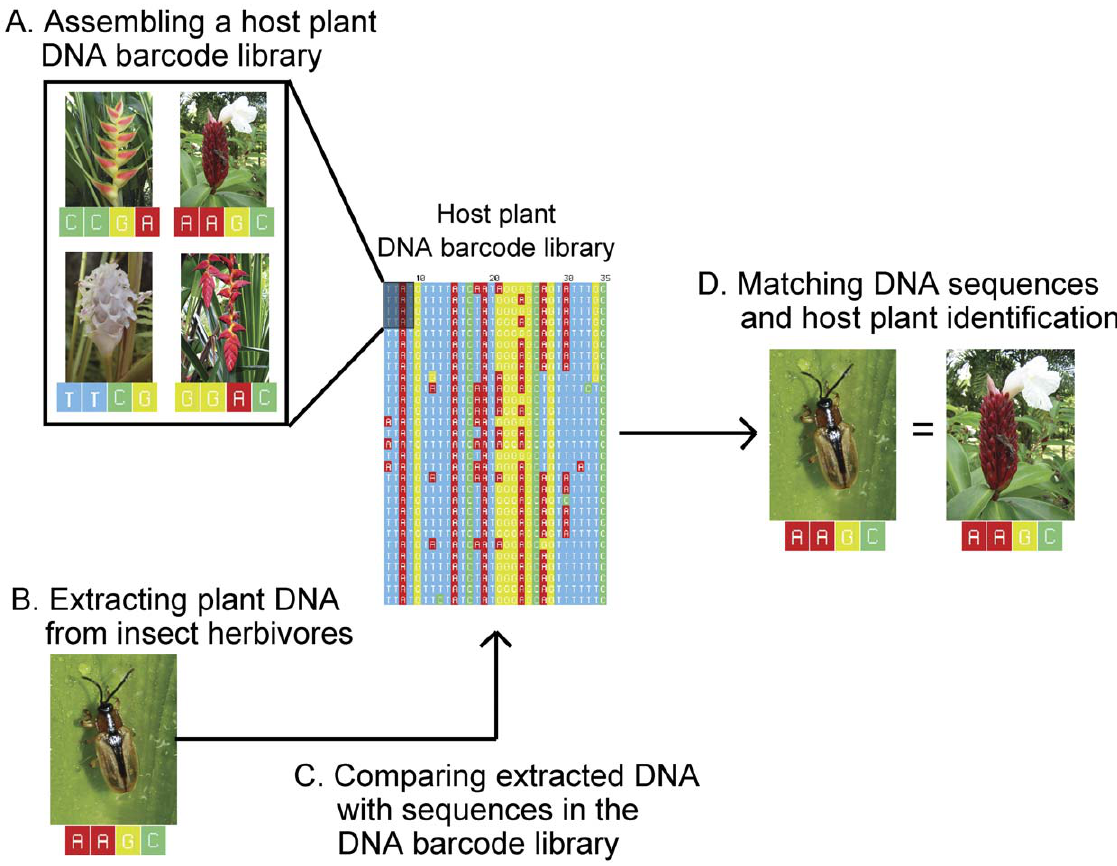
Figure 1. Diet identification using DNA barcodes. First we assembled a DNA barcode library containing sequences of all potential host plants ( A ). After collecting insect herbivores in the field ( B ), we extracted plant DNA from gut contents ( C ). Host plant identifications were performed by comparing DNA sequences extracted from insect herbivores to sequences in the DNA barcode library using the BLAST algorithm and default search parameters ( D ).